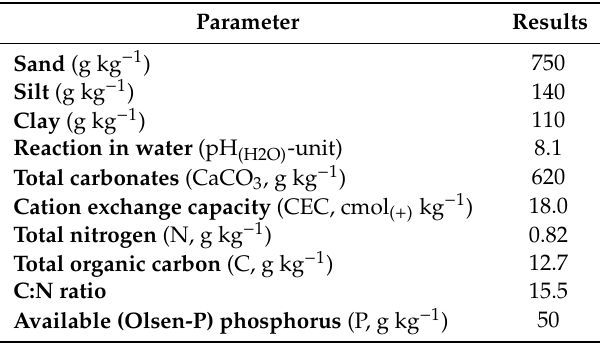
Table 1. The main physico-chemical characteristics of the soil used in the